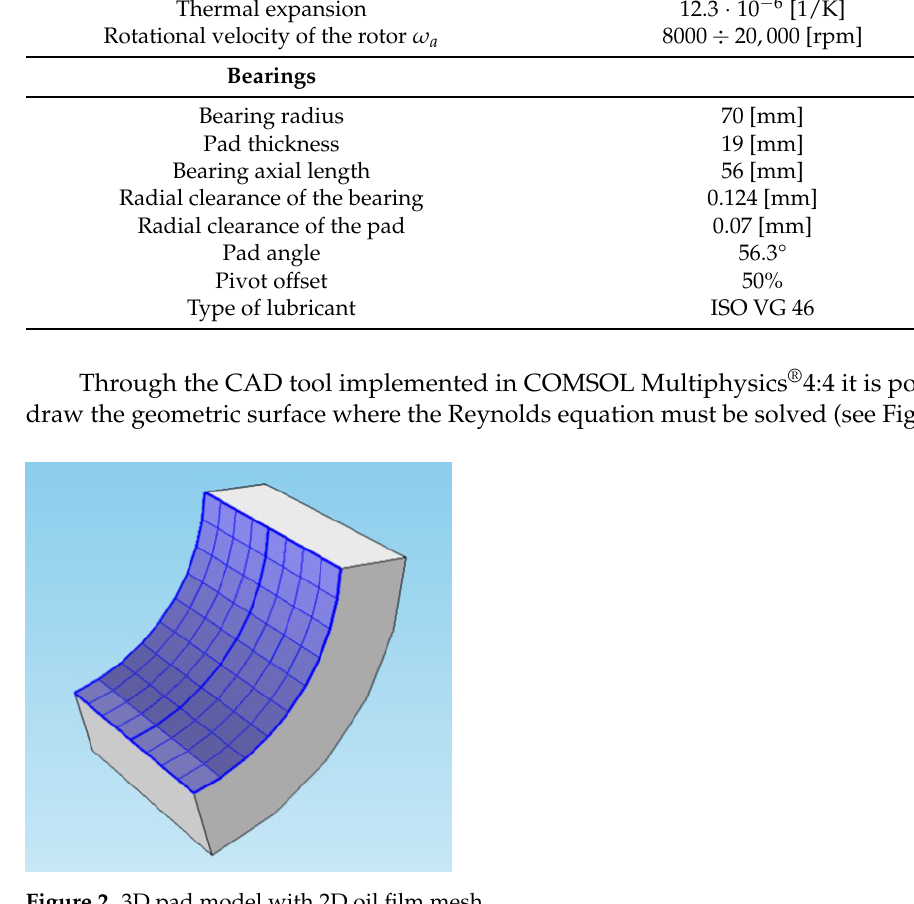
Figure 2. 3D pad model with 2D oil film